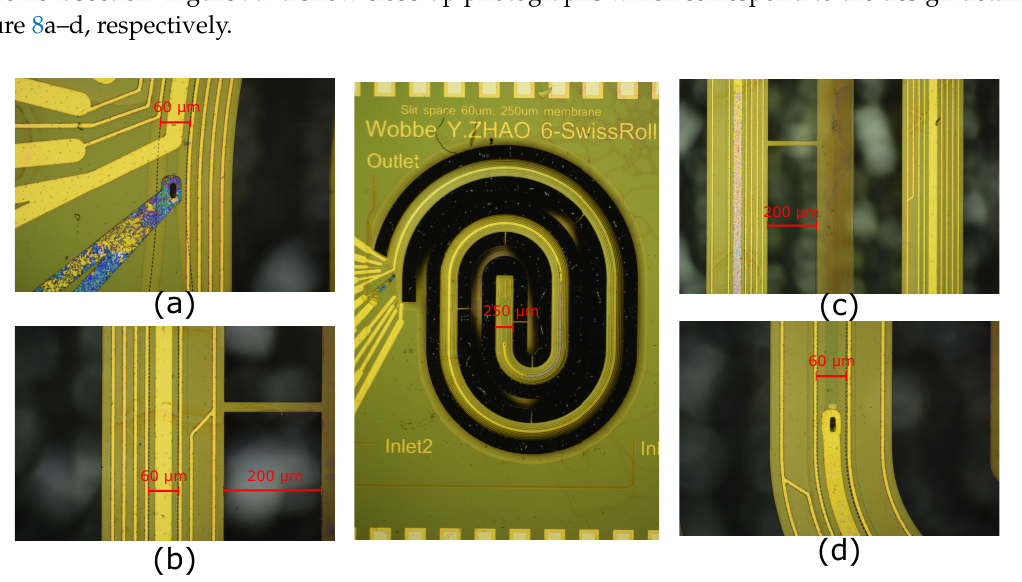
Figure 9. The optical microscope images of a demonstrator chip fabricated by the modified SCT